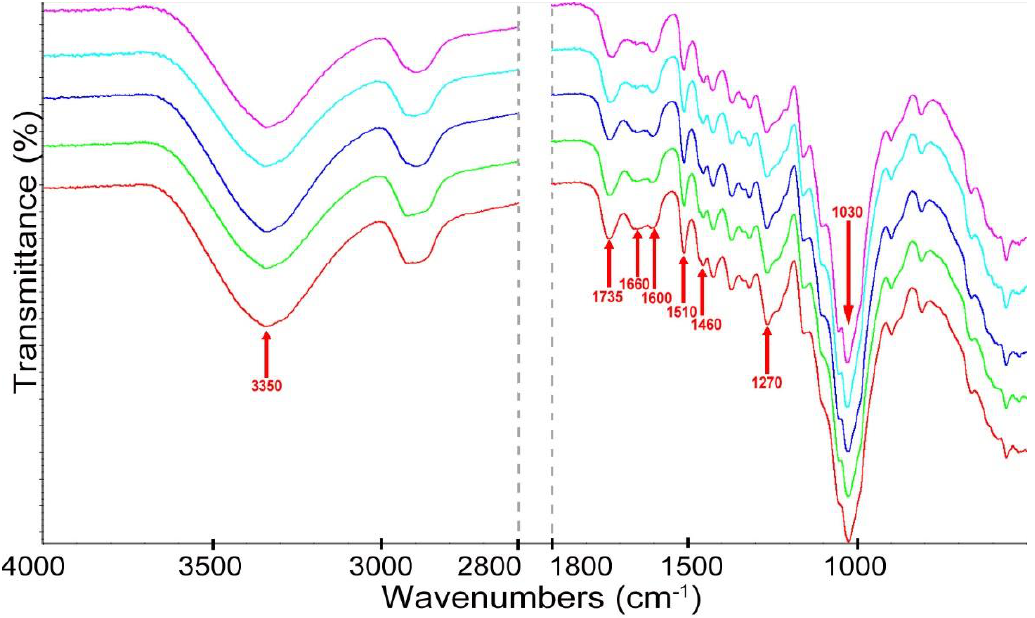
Figure 7. The ATR-FTIR spectra of control wood ( – ), wood modified at 130 °C ( – ), 160 °C ( – ), 190 °C ( – ) and 220 °C ( – ).